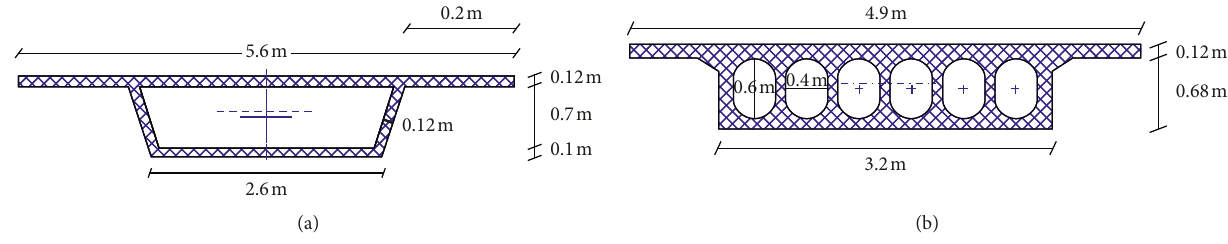
Figure 11: Cross section: (a) box girder; (b) posttensioned voided slab.